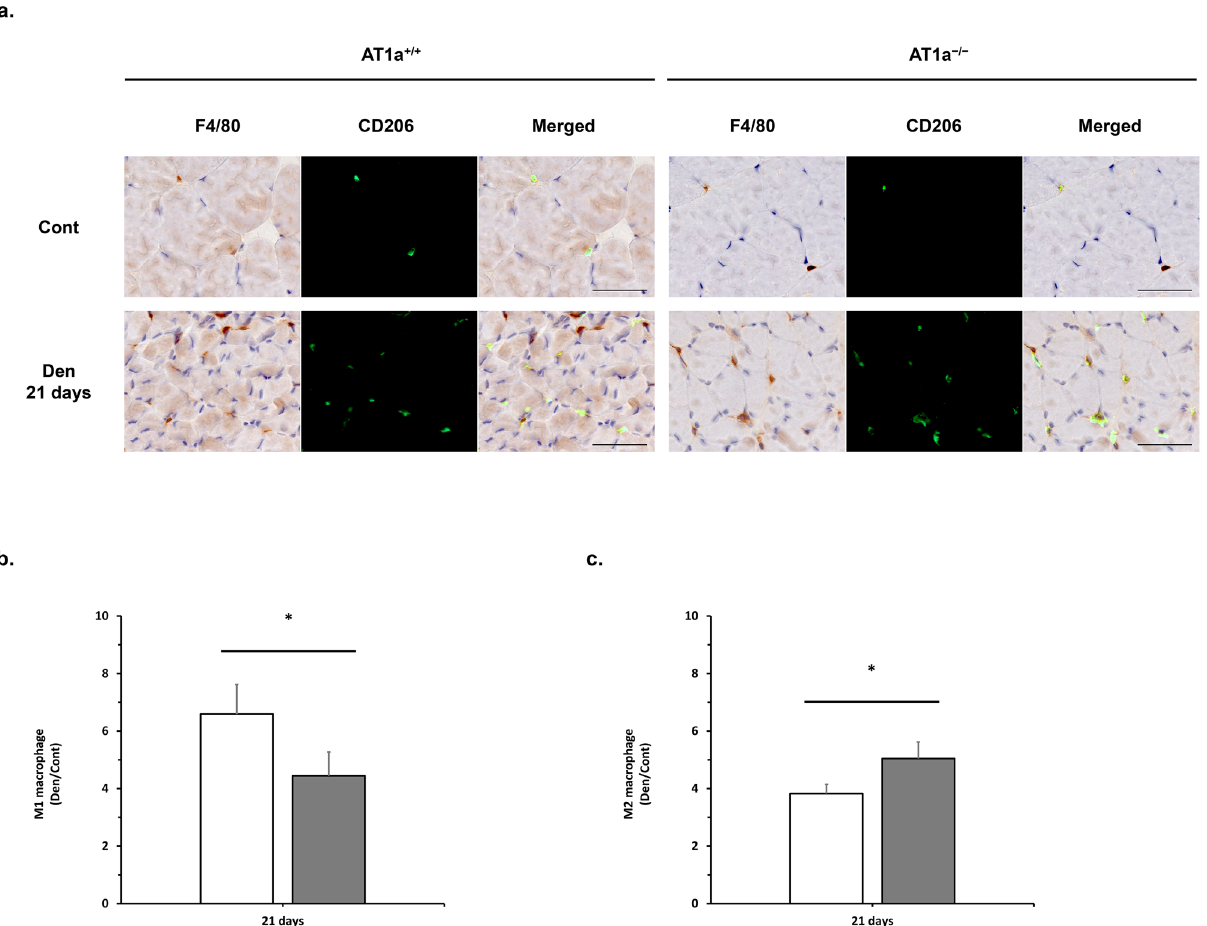
Figure 4. AT1a receptor loss modulated M1/M2 macrophage polarization in the denervated gastrocnemius muscle. ( a ) Immunostaining of gastrocnemius muscle in each AT1a +/+ and AT1a −/− mice at 21 days postdenervation. Immunostaining shows codistribution of M1 and M2 macrophages. Anti-F4/80 antibody binds M1 macrophages and M2 macrophages (brown color). Anti-CD206 antibody binds M2 macrophages (green fluorophore). CD206 - /F4/80 + cells are M1 macrophages. CD206 + /F4/80 + cells are M2 macrophages. Scale bar: 50 μm. ( b , c ) The degrees of infiltrated M1 macrophage ( b ) and M2 macrophage ( c ) were shown as the fold increase or decrease in the Den group compared with the Cont group in immunohistochemistry analysis. AT1a +/+ -Cont group, n = 6; AT1a +/+ -Den group, n = 7; AT1a −/− -Cont group, n = 5; AT1a −/− -Den group, n = 6. Values are means ± SE. * P < Animal characteristics and change in skeletal muscle weight. The levels of body weight measured before dener- vation were significantly higher in each AT1a −/− -Cont and AT1a −/− -Den group than in each AT1a +/+ -Cont and